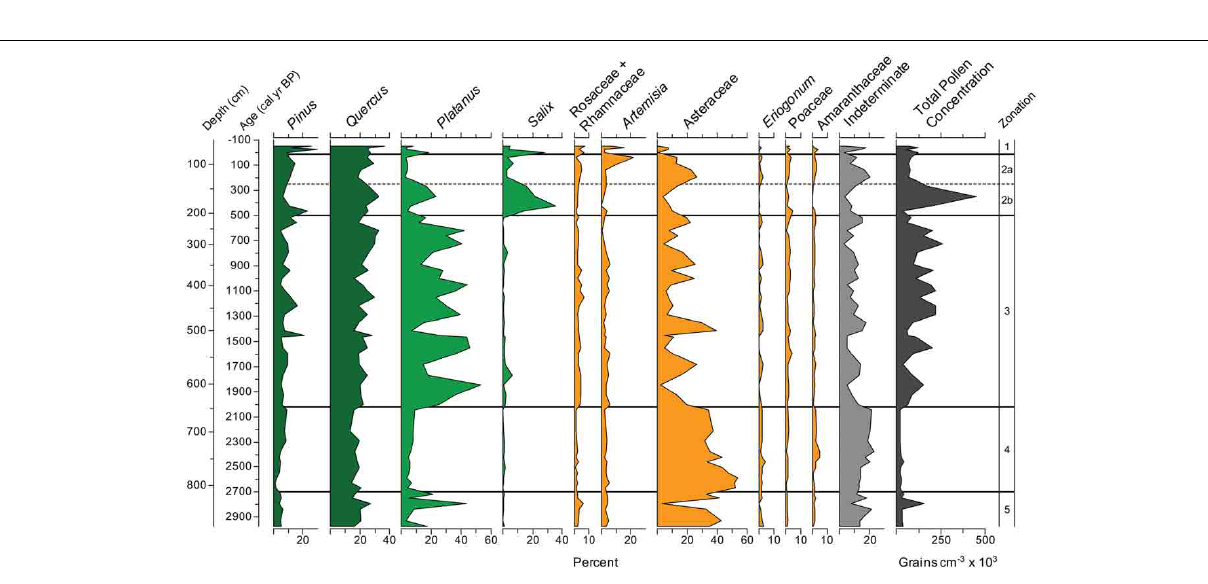
FIGURE 5 | Zaca Lake pollen percentages for the ten most common taxa plotted with indeterminate grains and total pollen concentration.